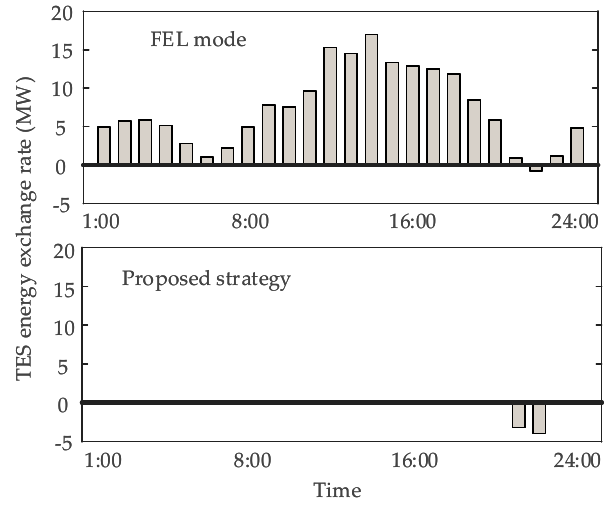
Figure 11. TES energy exchange in summer case with 0.75 power to heat ratio.